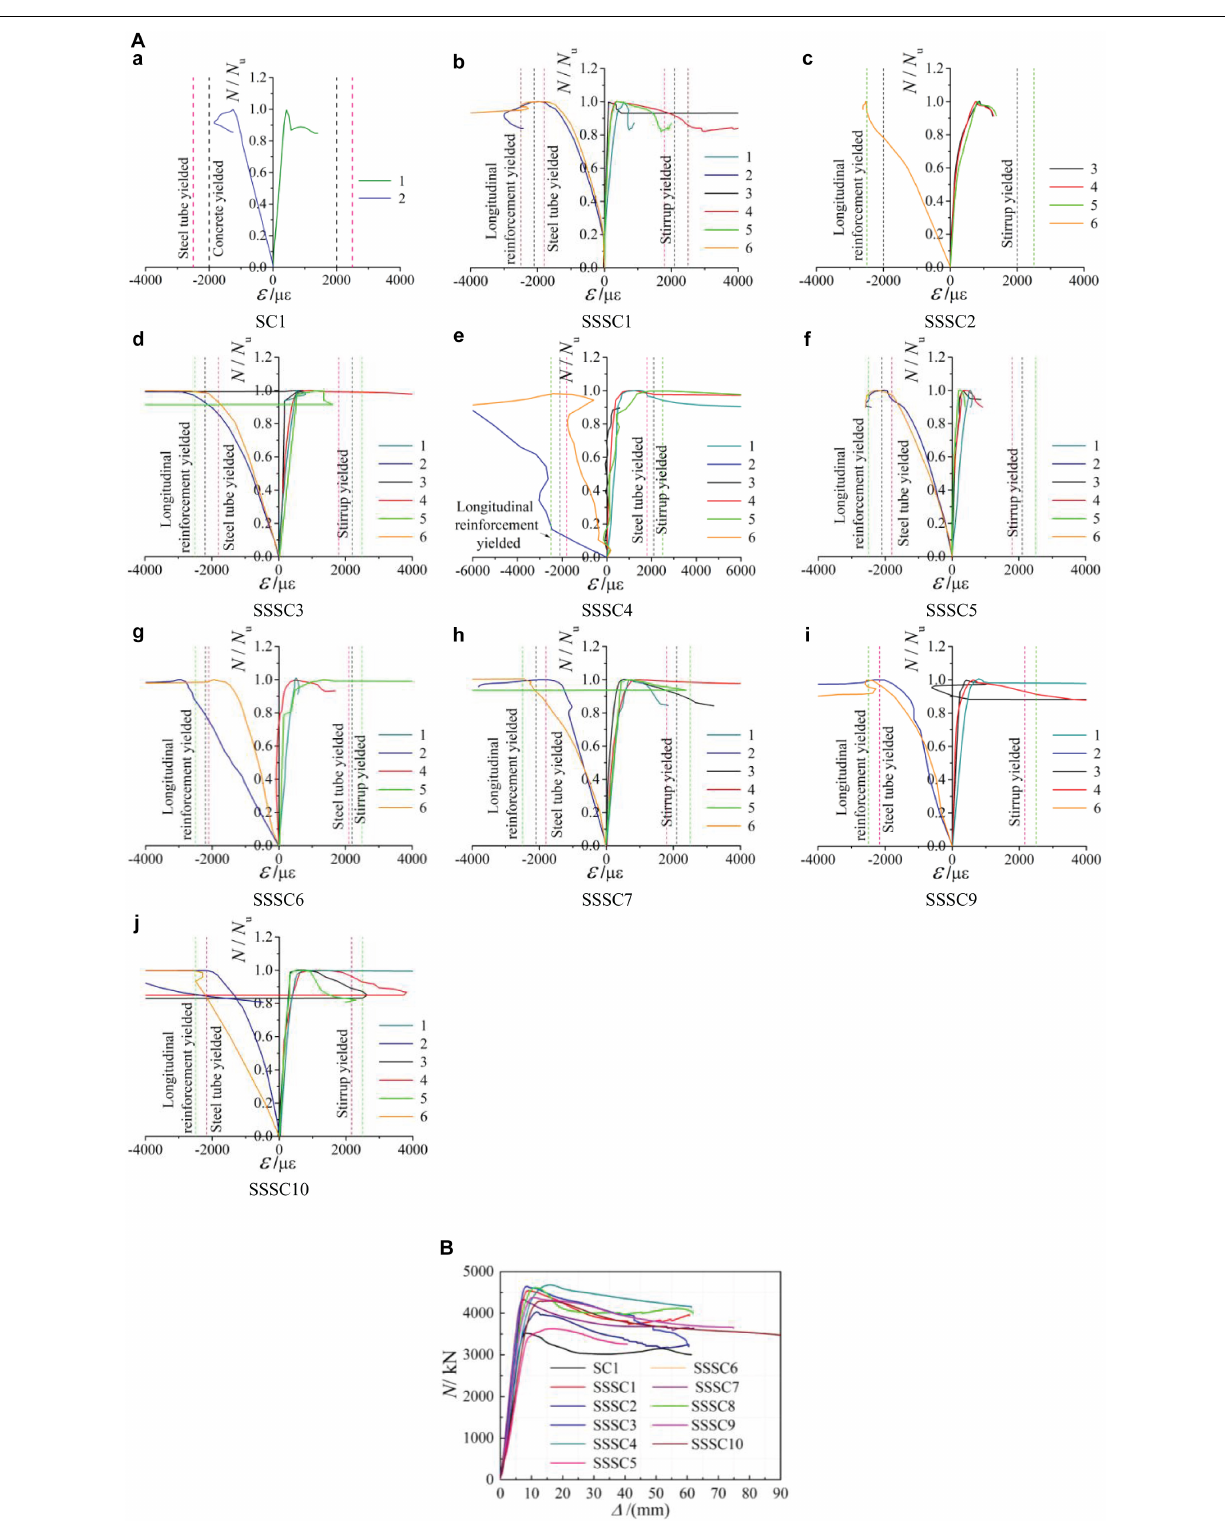
Frontiers in Materials |